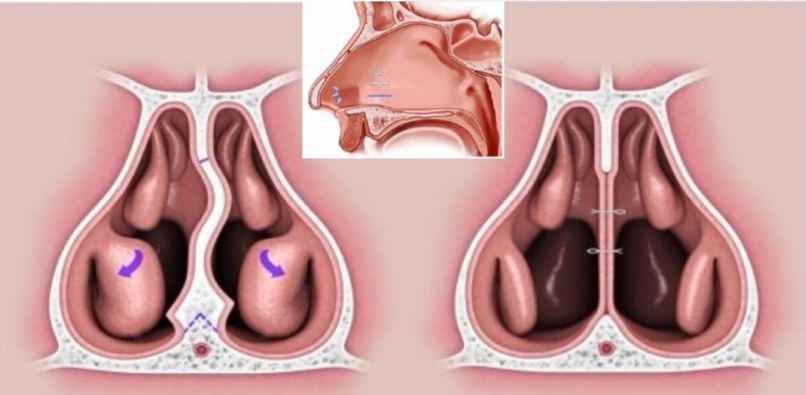
Figure 2. Mini-invasive septoturbinoplasty (MIST) involves excision of deviated septum, triangular hump preservation of nasal floor, incision drainage along nasal floor and trans-septal sutures and out-fracture of inferior turbinate. Arrow: out-fracture of inferior turbinate.